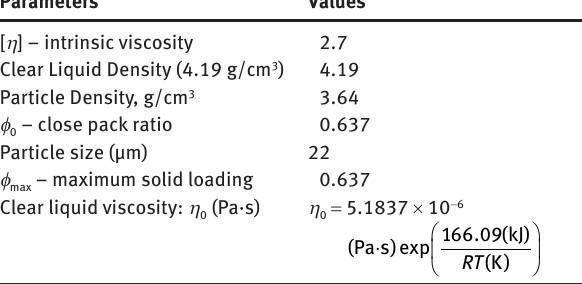
Table 5: Pertinent parameters used in Veytsman’s model